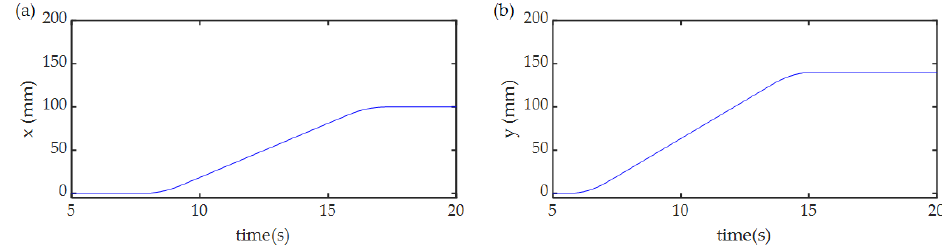
Figure 10. The evaluated motion stroke data of the dual servo stage: ( a ) x direction, ( b ) y direction. Table 7. The evaluated in-position stability of the dual servo stage with RMS values.